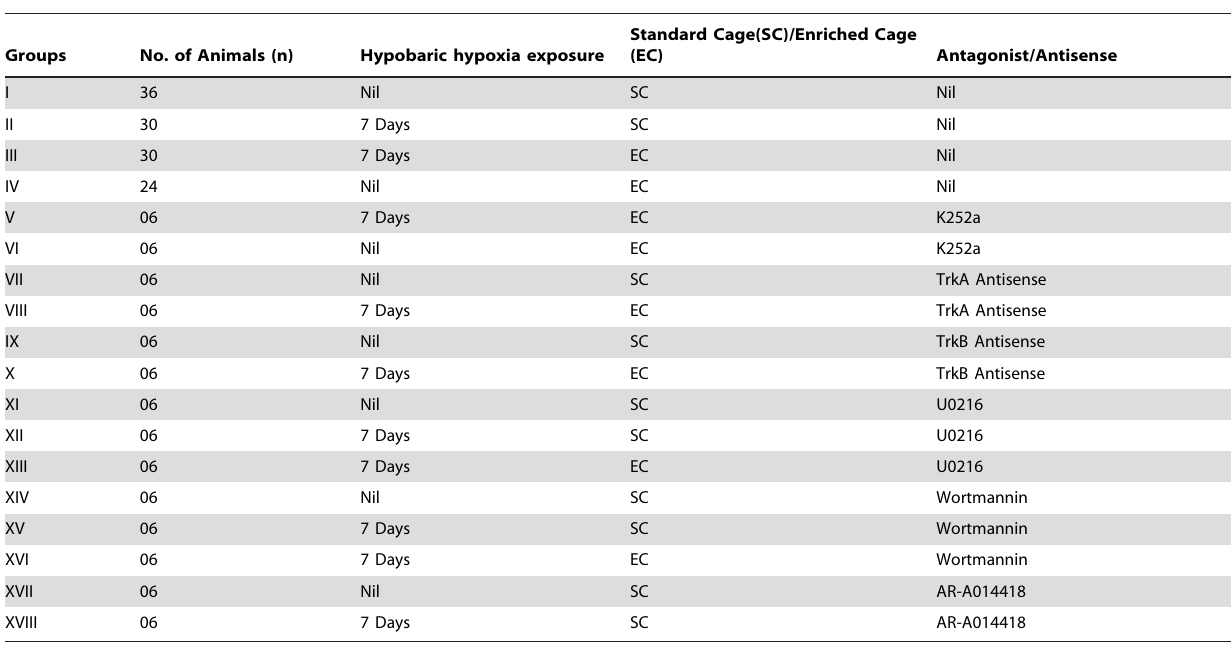
Table 1. Shows experimental design describing groups, number of individuals, exposure duration and interventions.